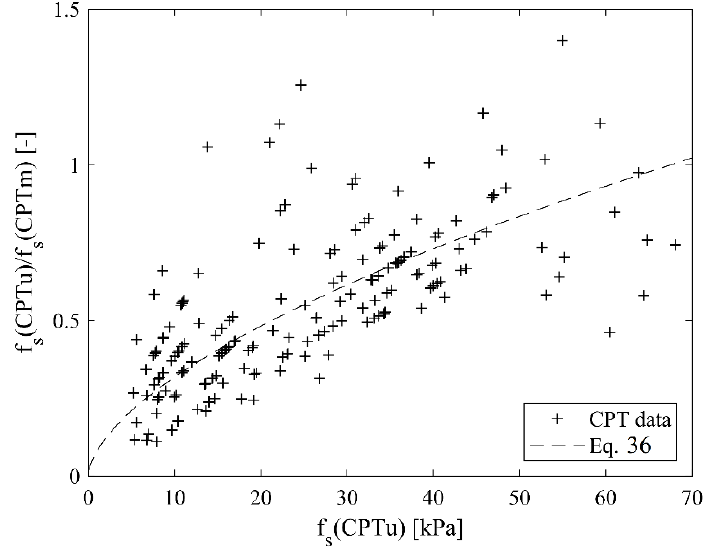
Figure 5. Correlation function between f s (CPTm) and f s (CPTu) .